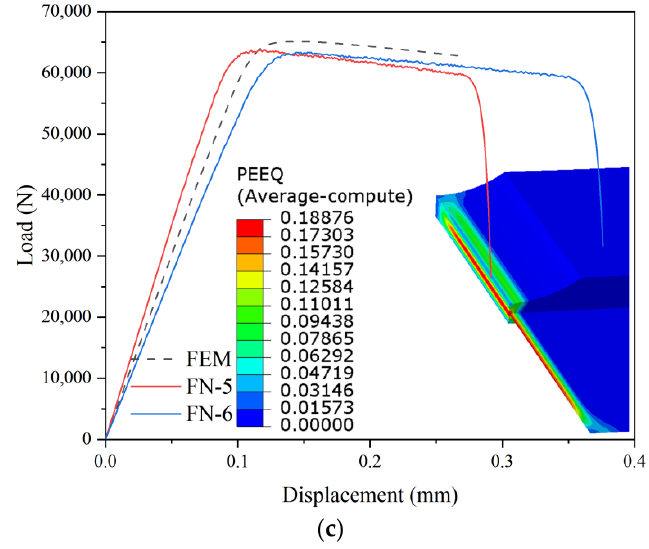
Figure 11. Contrast of load–displacement behavior between the tensile test and the finite element method for the flat grooved plate specimens: ( a ) FN-1 and FN-2 (notch arc radius = 1 mm), ( b ) FN-3 and FN-4 (notch arc radius = 5 mm), ( c ) FN-5 and FN-6 (notch arc radius = 10 mm).